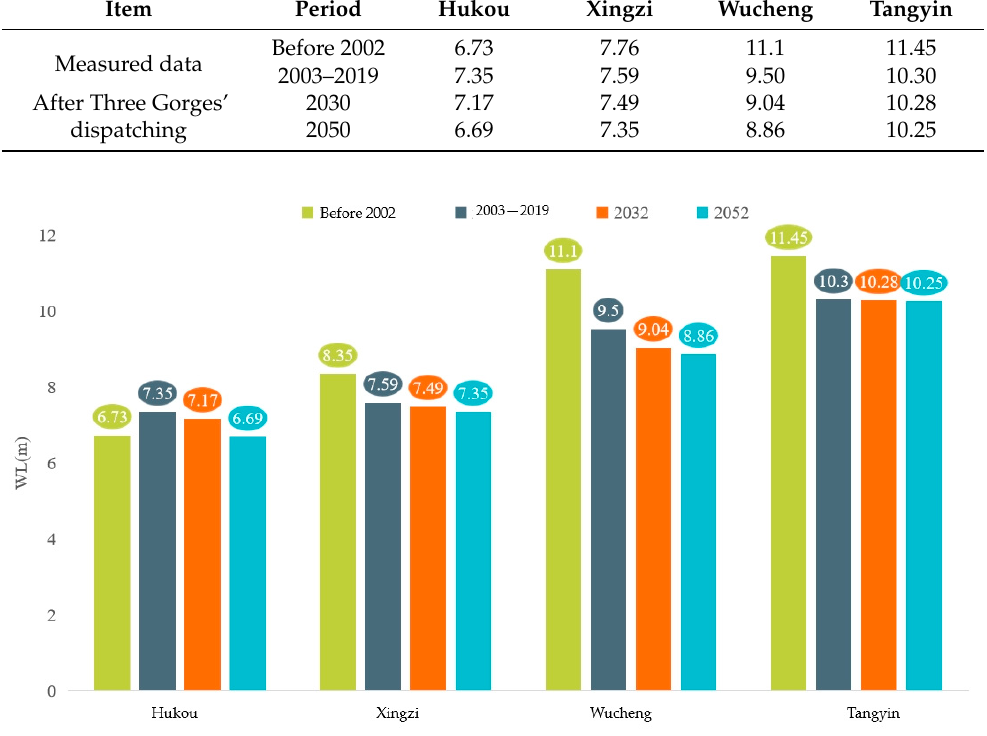
Table 1. Analysis of the navigation dependable water level in Poyang Lake (unit: m).